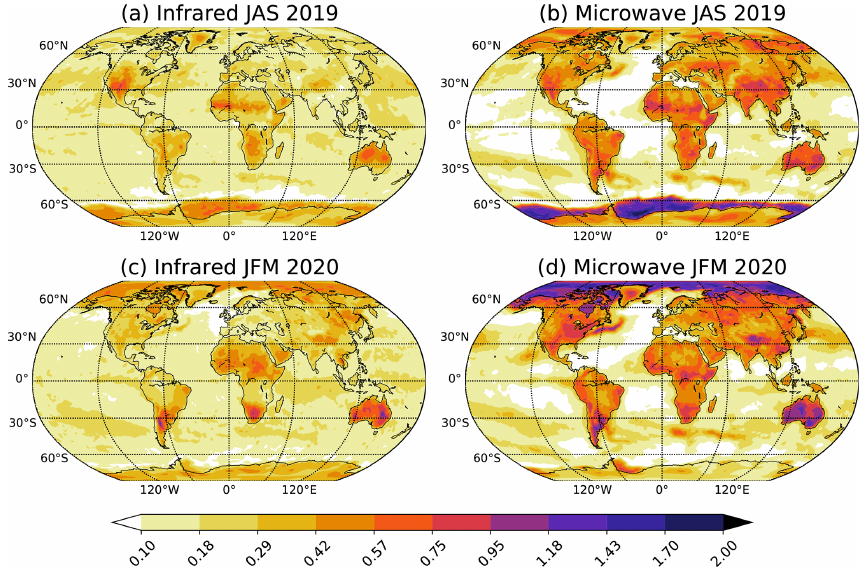
Figure 2. Standard deviation of the skin temperature increment (in K) from the SKTECV experiment for (a, b) JAS 2019 and (c, d) JFM 2020 for (a, c) the infrared field and (b, d) the microwave